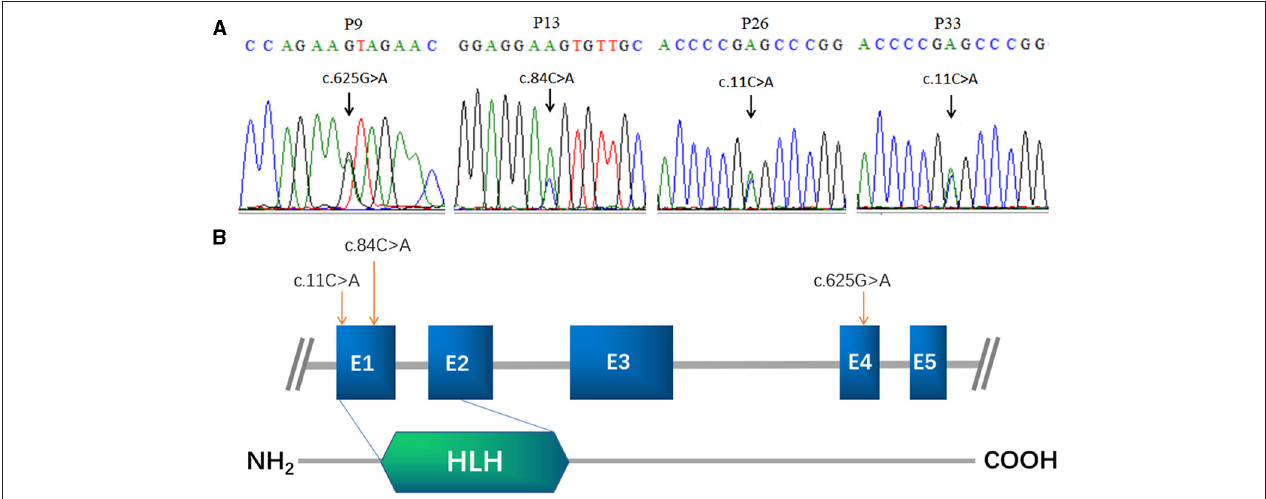
FIGURE 1 | FIGLA mutation identification in POI patients. Sequencing showing the c.625G > A mutation in patient 9, the c.84C > A mutation in patient 13 (A) , and the c.11C > A mutation in patient 26 and patient 33 (B) . The human FIGLA gene is schematically drawn with five known exons (blue boxes); the c.84C > A and c.11C > A mutations are located in the FLGLA HLH domain (green rhombus).